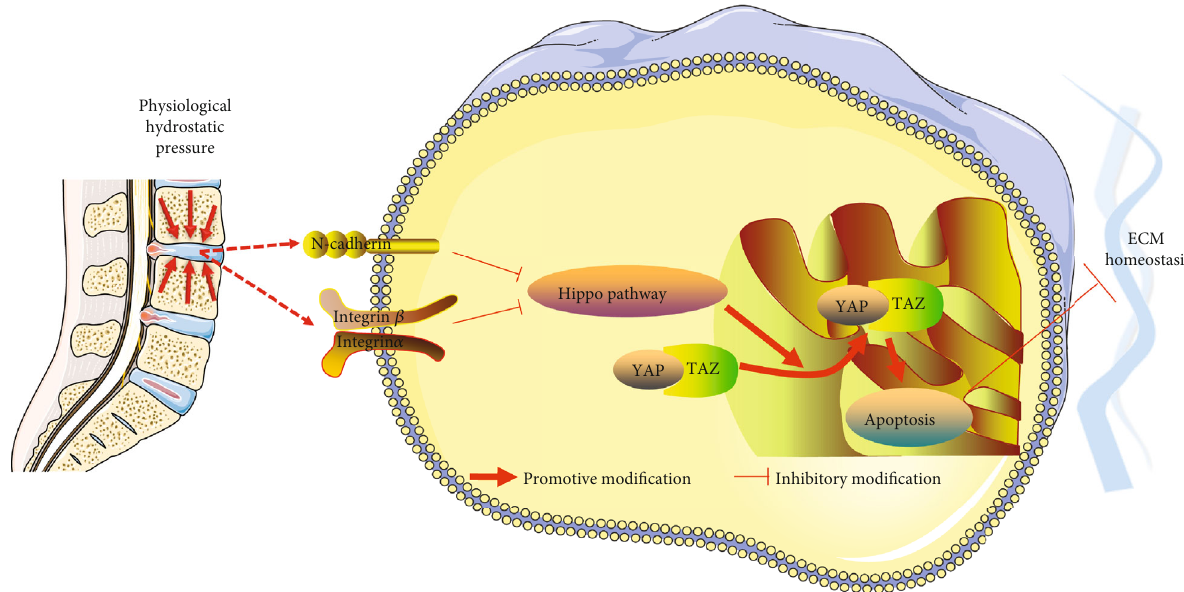
Figure 8: Schematic diagram shows the potential mechanism of physiological hydrostatic pressure e ff ects the IVD cell survival and ECM homeostasis: low-loading physiological hydrostatic pressure activates mechanosensitive factors N-CDH and integrin β 1, which inhibit Hippo-YAP/TAZ pathway-mediated cell apoptosis and ECM